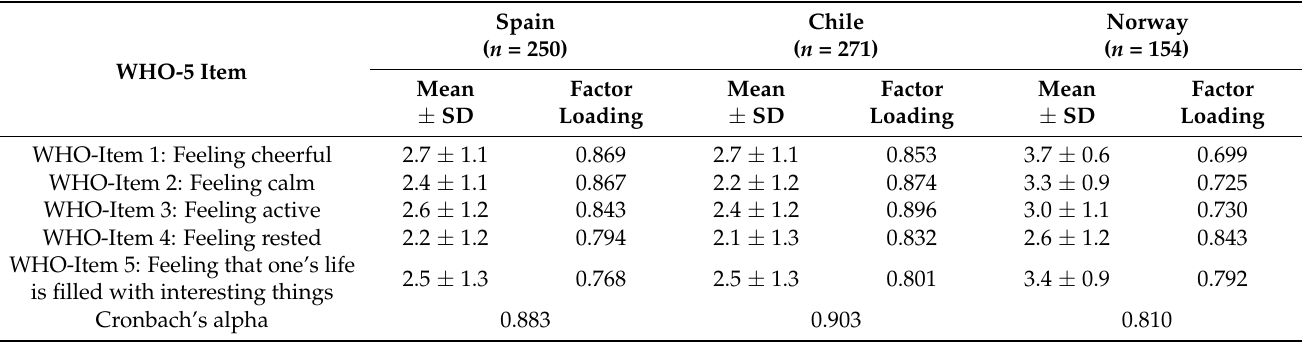
Table 2. Means (M), standard deviation (SD, ± ), factor loading and Cronbach’s alpha for the three samples.